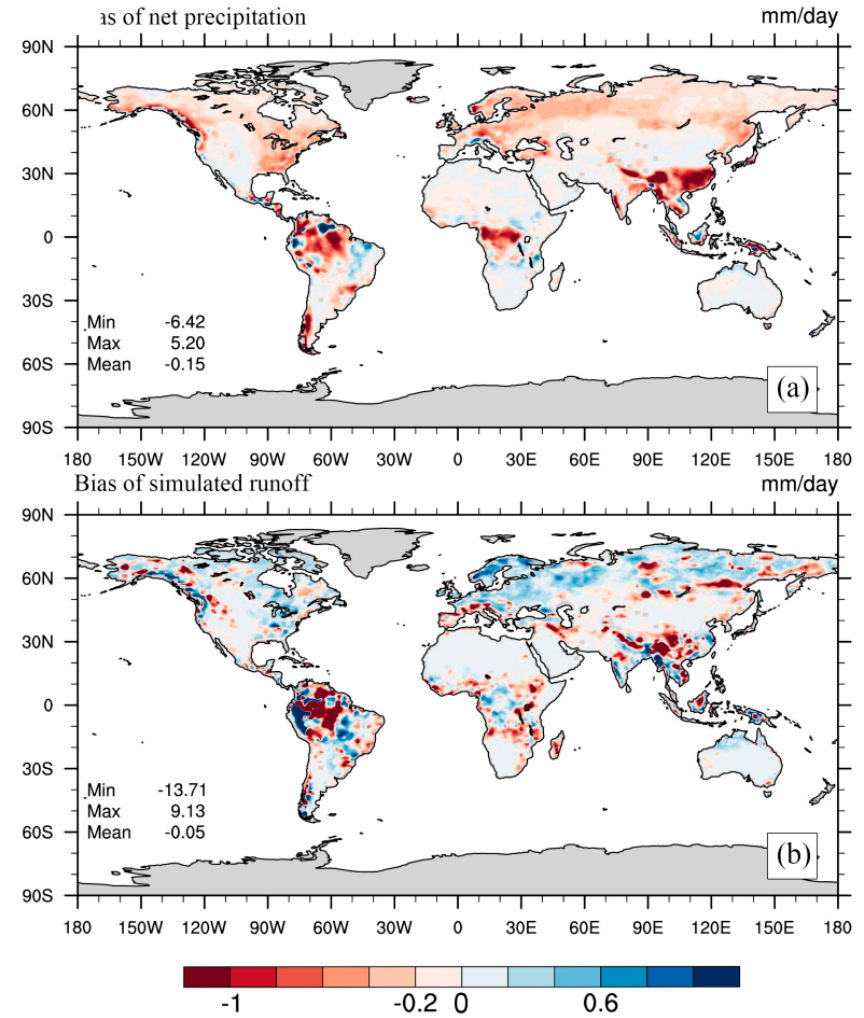
Figure 3. Annual mean ( a ) net precipitation forcing based on Climate Research Unit–National Centers for Environmental Prediction (CRUNCEP) minus that based on the QIAN data set (mm day − 1 ) and ( b ) simulated runoff in CLM4.5 driven by QIAN data minus Global Composite Runoff Data Set (GRDC) total runoff (mm day − 1 ).